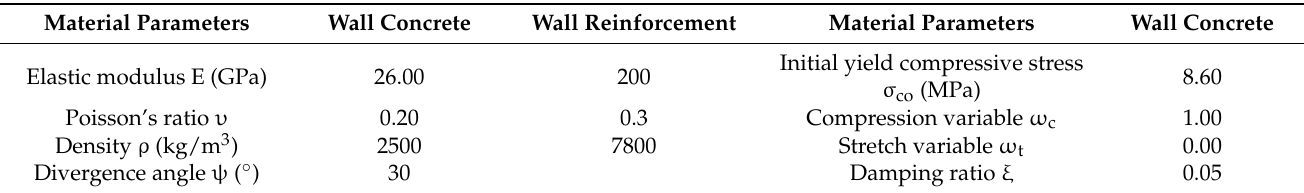
Table 7. Material parameters.